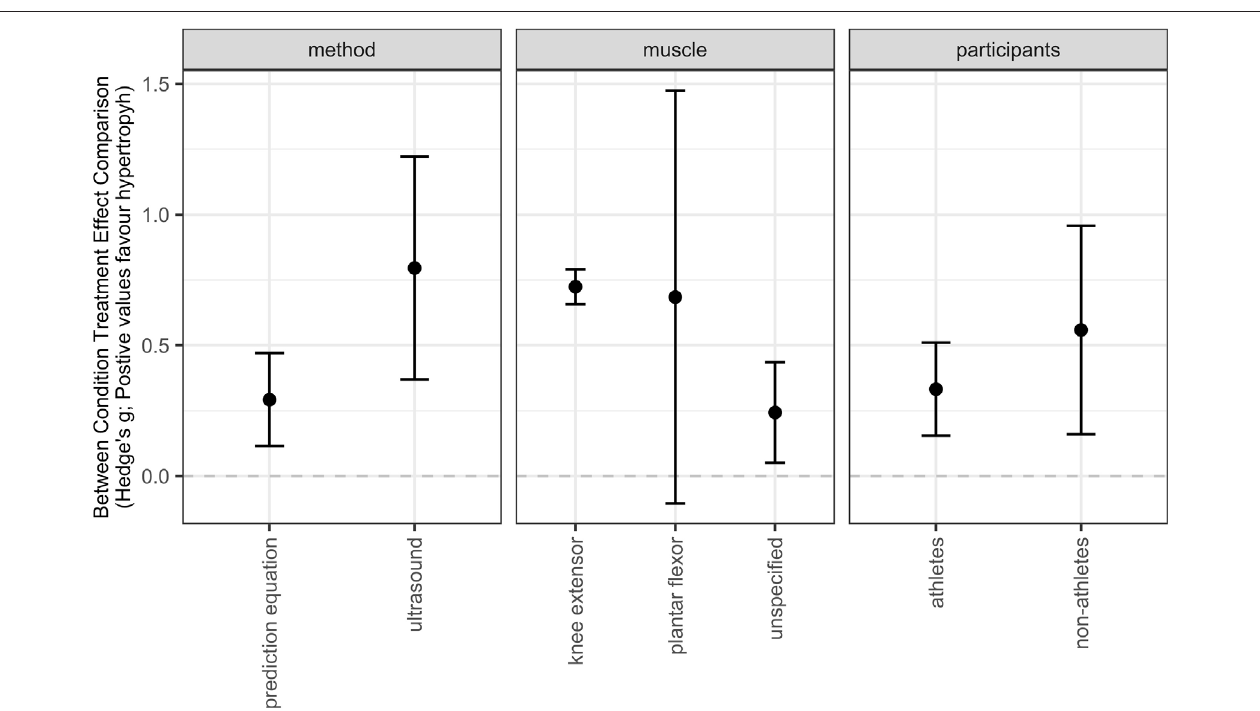
FIGURE 4 | Point-range plots of categorical subgroups on skeletal muscle